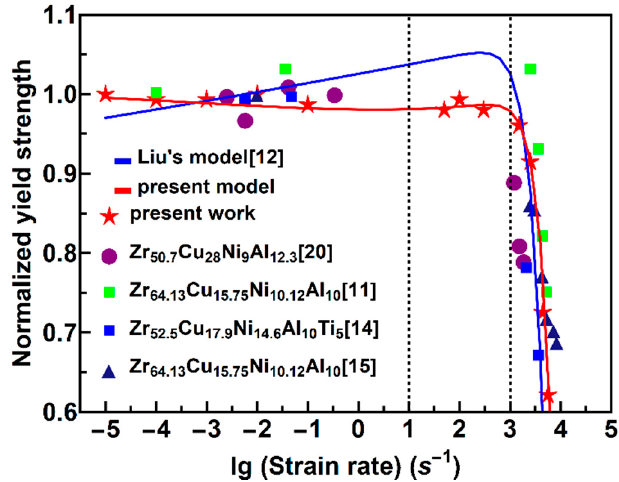
Figure 8. Relationship between the normalized yield strength and the strain rate.